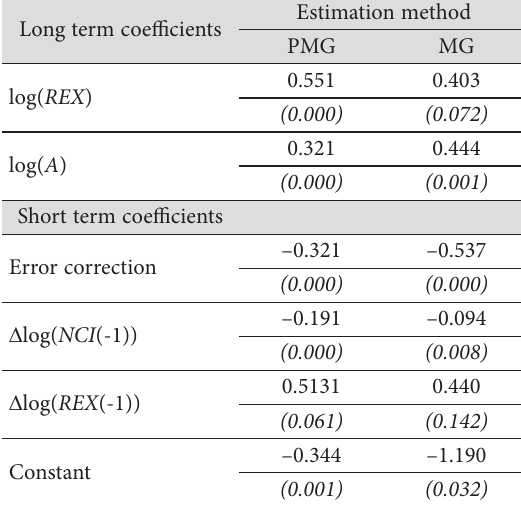
Table 3. Net fee and commission income estimation